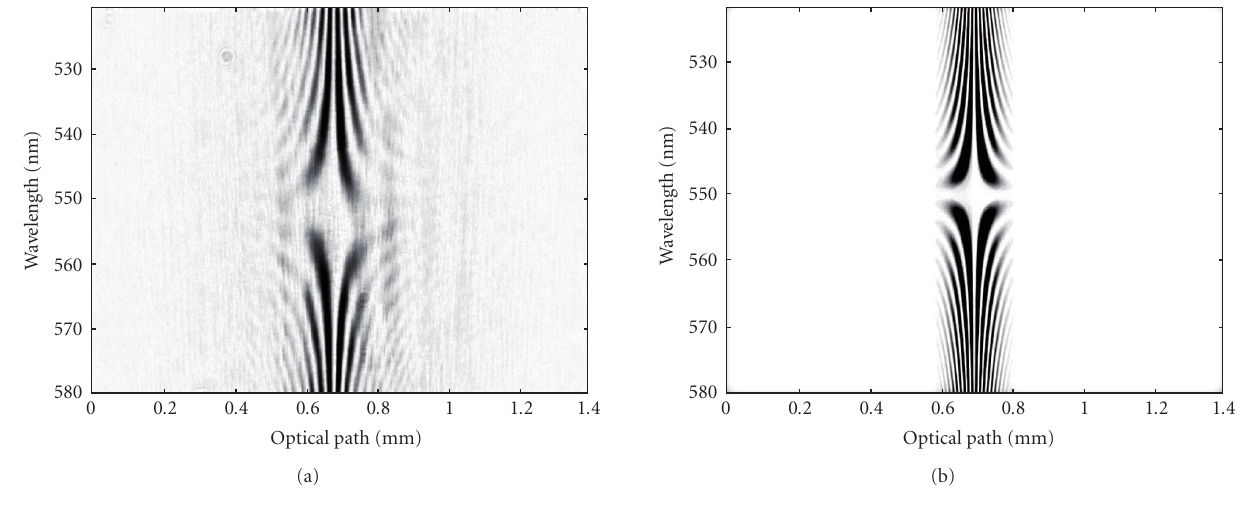
Figure 4: Experimental (a) and simulated (b) spectrotomograms.